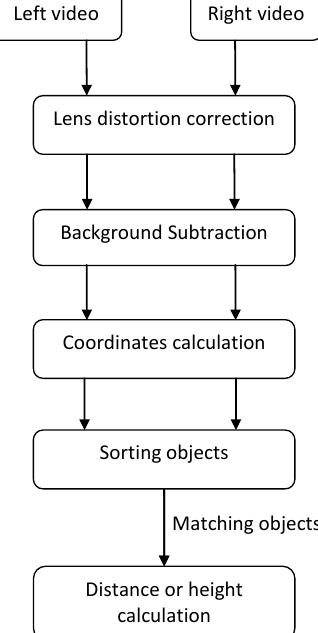
Figure 3. Involved process to calculate distance & height of moving